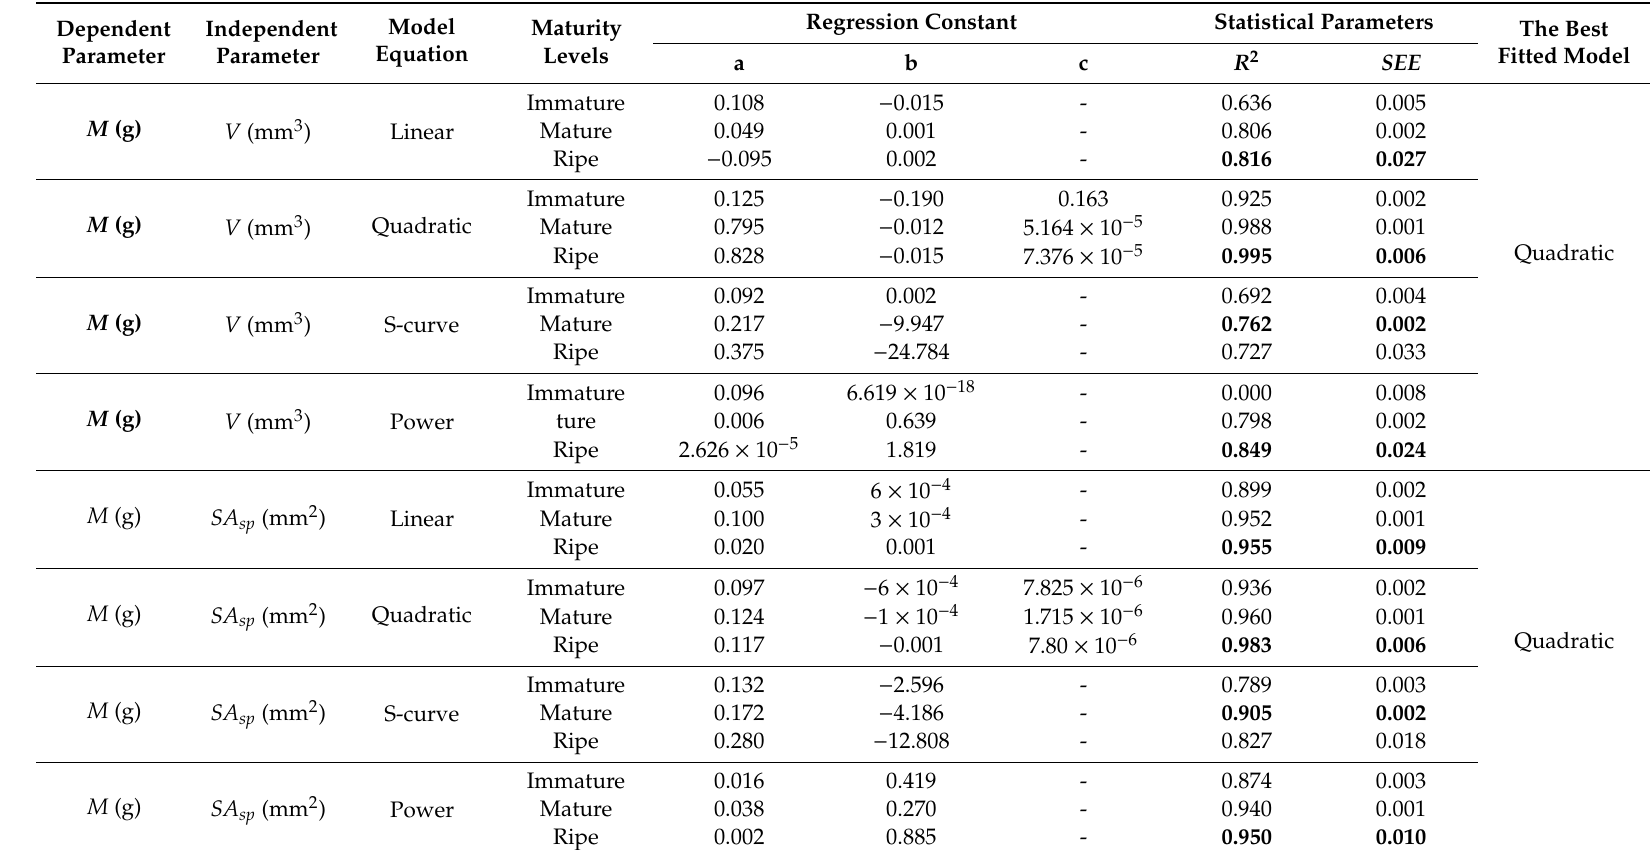
Table 3. Mass models of pepper berries based on volume and surface